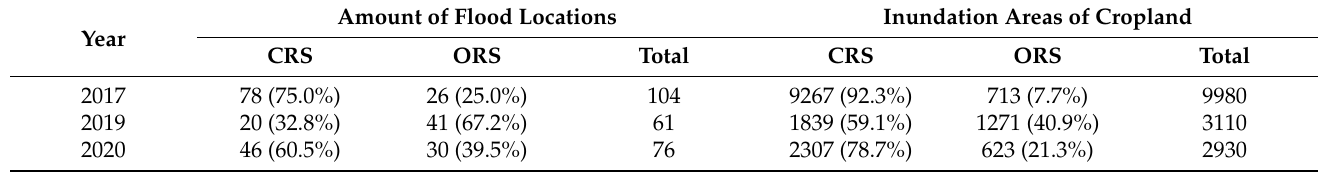
Figure 8. Critical river channels with higher flood risk. Table 6. Statistics for the number of flood locations and inundated croplands (unit: hectare) along critical river sections (CRS) and other river sections